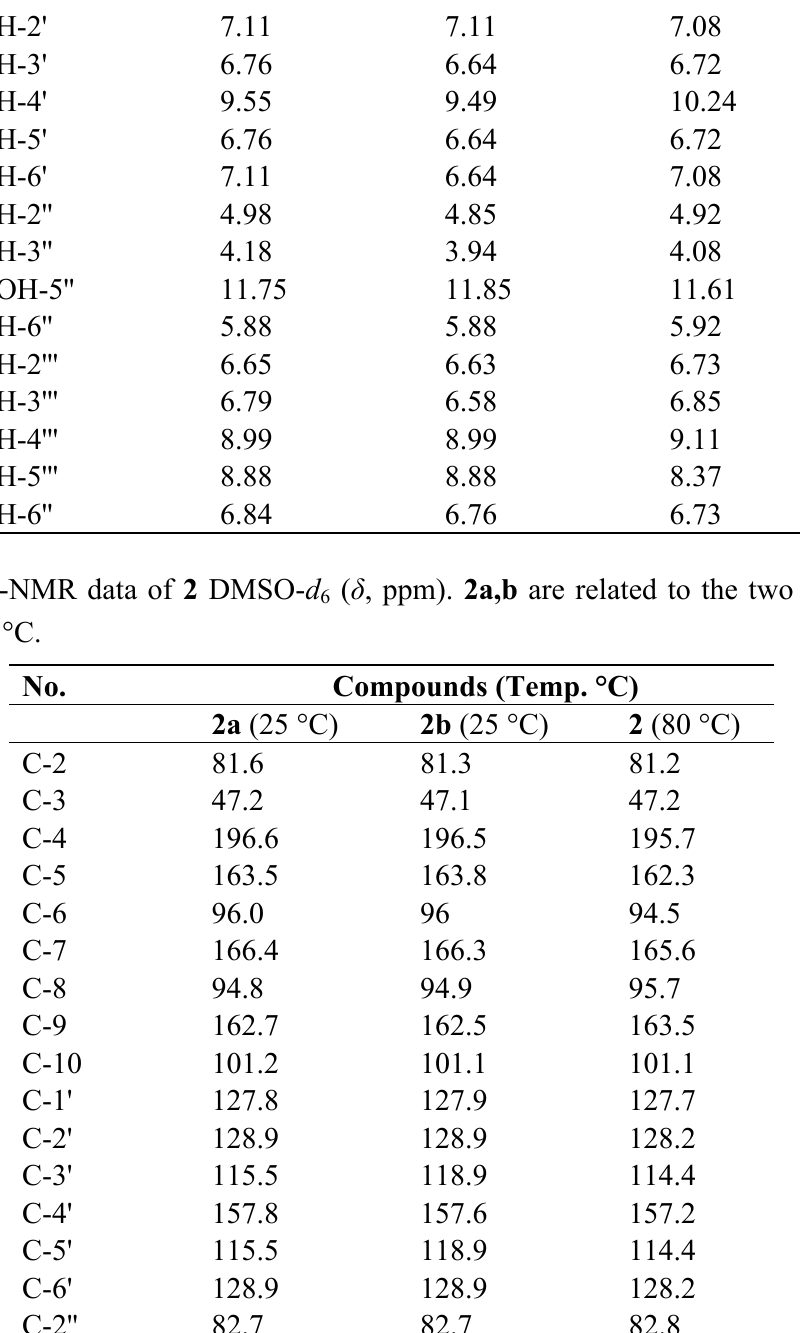
Table 1. 1 H-NMR (600 MHz) data of 2 in DMSO- d 25 °C and 80 °C. 2a,b denote the two conformers present at 25 °C.